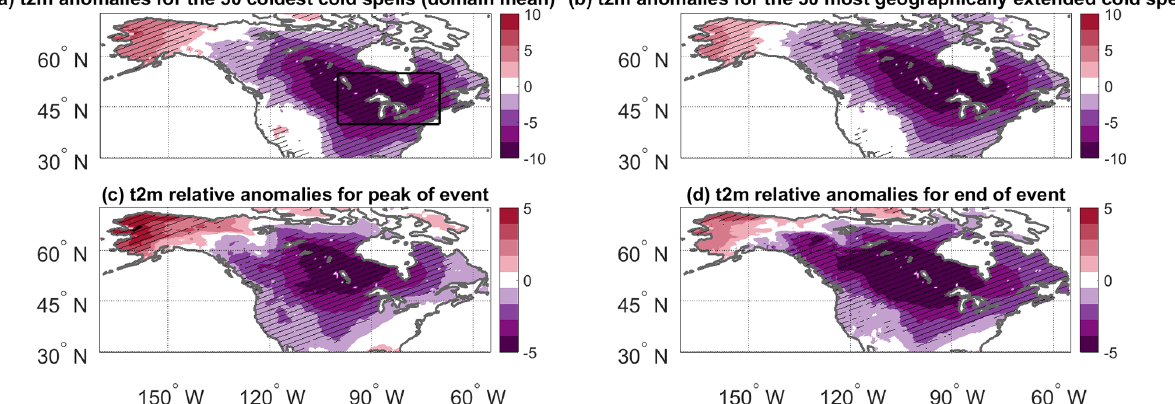
Figure 4. Composite-mean 2m temperature (t2m) anomalies (K) for (a) the 50 cold spells with the lowest area-averaged t2m anomaly over 40–55 ◦ N, 260–290 ◦ E (black box) and (b) the 50 cold spells with the most grid points below the local 5th percentile of t2m anomalies over the same domain. In both cases, a minimum separation of 5d is enforced between different cold spells. Composite t2m anomalies (K) relative to onset of reflection events for (c) the peak and (d) the end of all reflection events. Hatching denotes statistically significant anomalies, assessed as described in Sect. 2. Note that the colour bar range differs between panels (a,b) and (c,d)